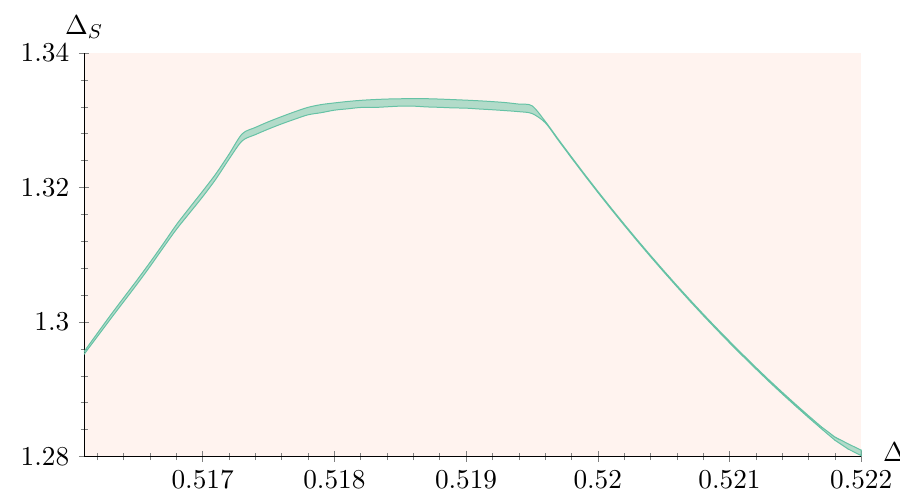
Figure 2: Plot of the allowed region (in green) with the assumptions (S-1)–(S-4). There appear to be two kinks in the allowed strip. It will become apparent from Fig. 3 that these two kinks arise at the points where this plot overlaps with the peninsula of allowed parameter space found in our previous work [ 16 ] .